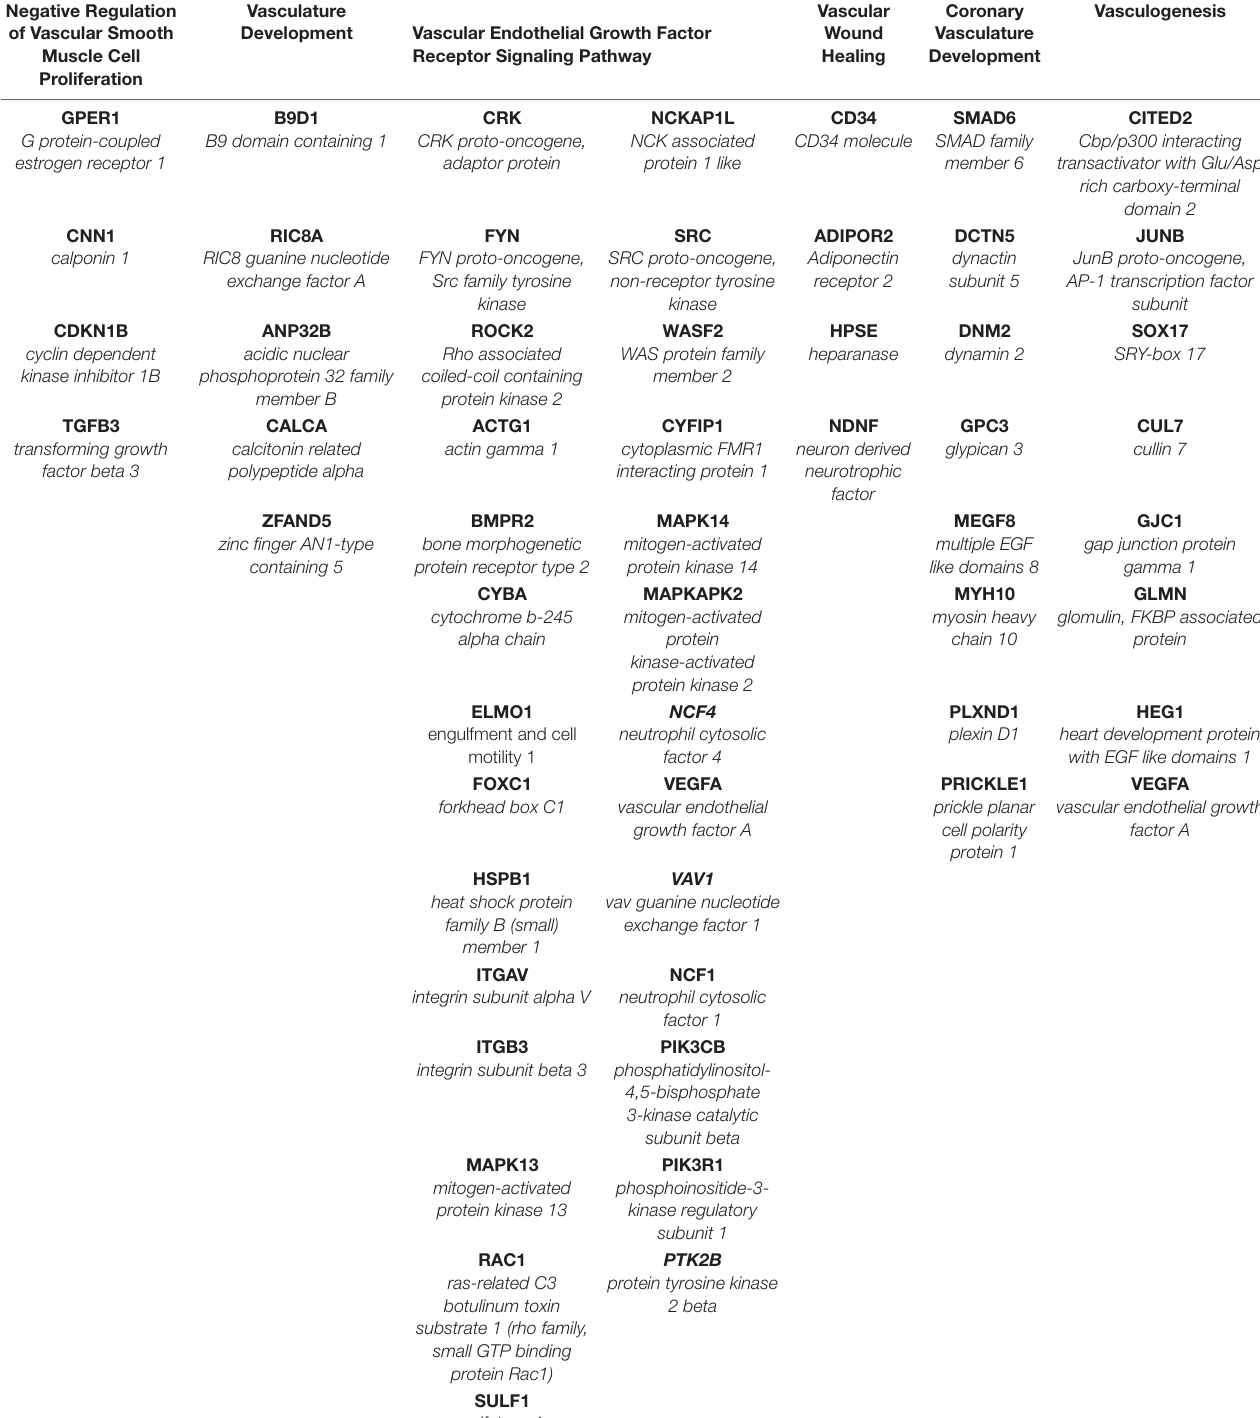
TABLE 2 | Functional annotation pathways modified by hypertension in